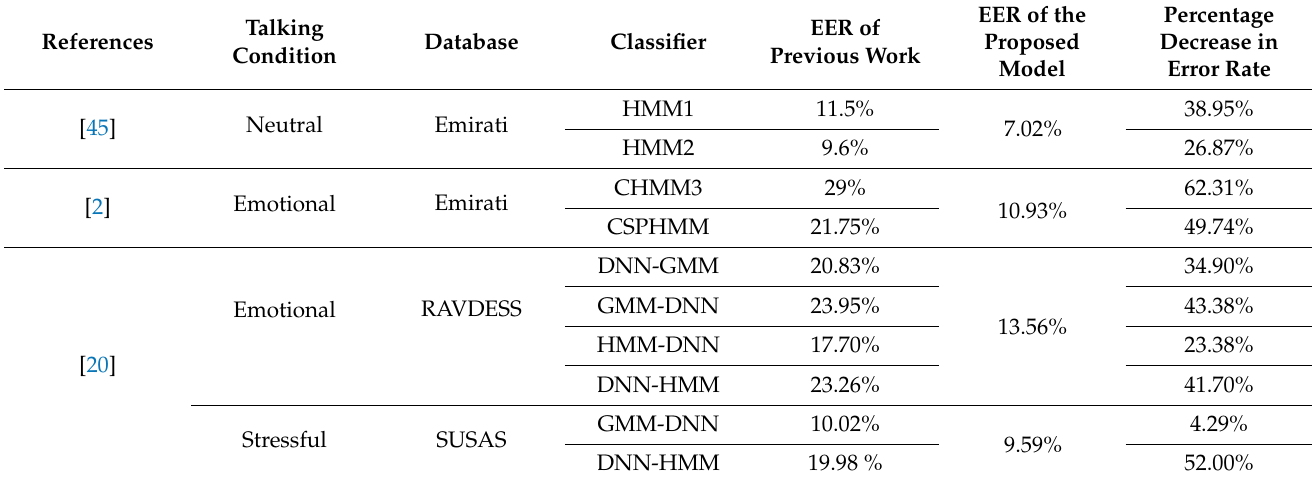
Table 12. Comparison with related